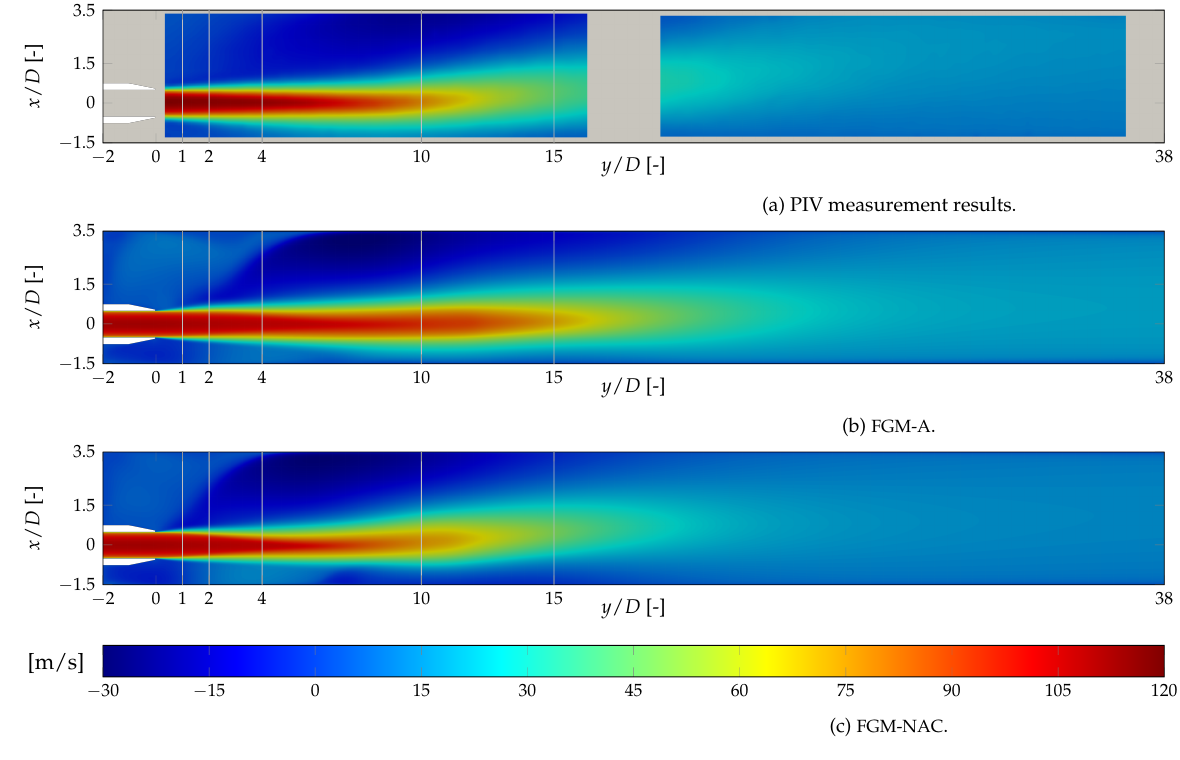
Figure 4. Streamlines along the symmetry surface coloured by velocity magnitude.